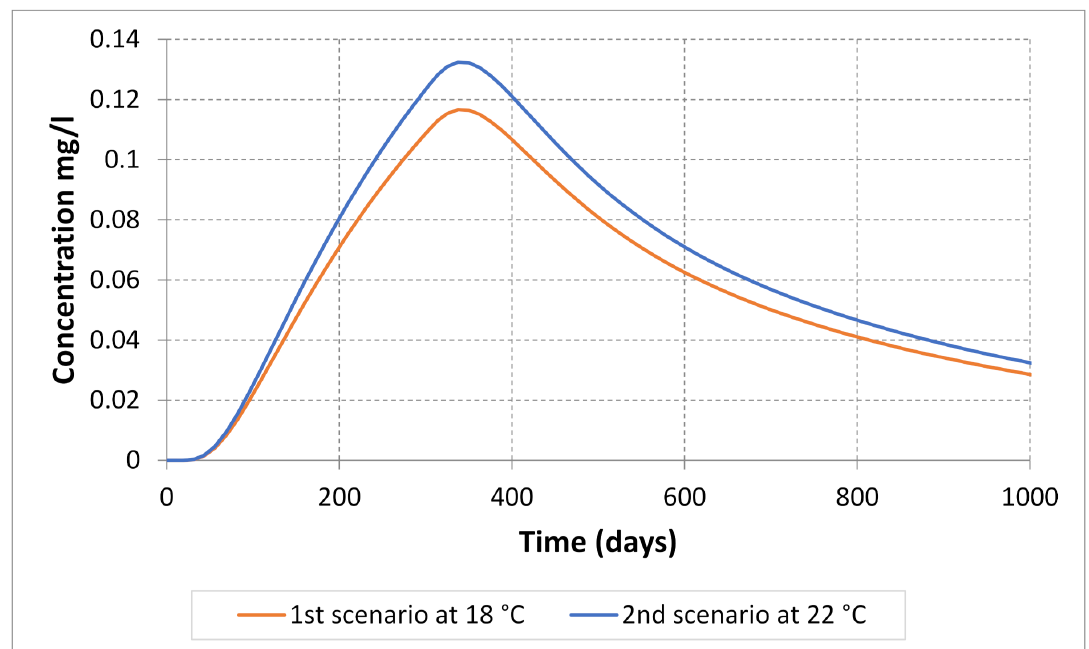
Figure 4. C max of benzene at depth 100 cm—Silt loam